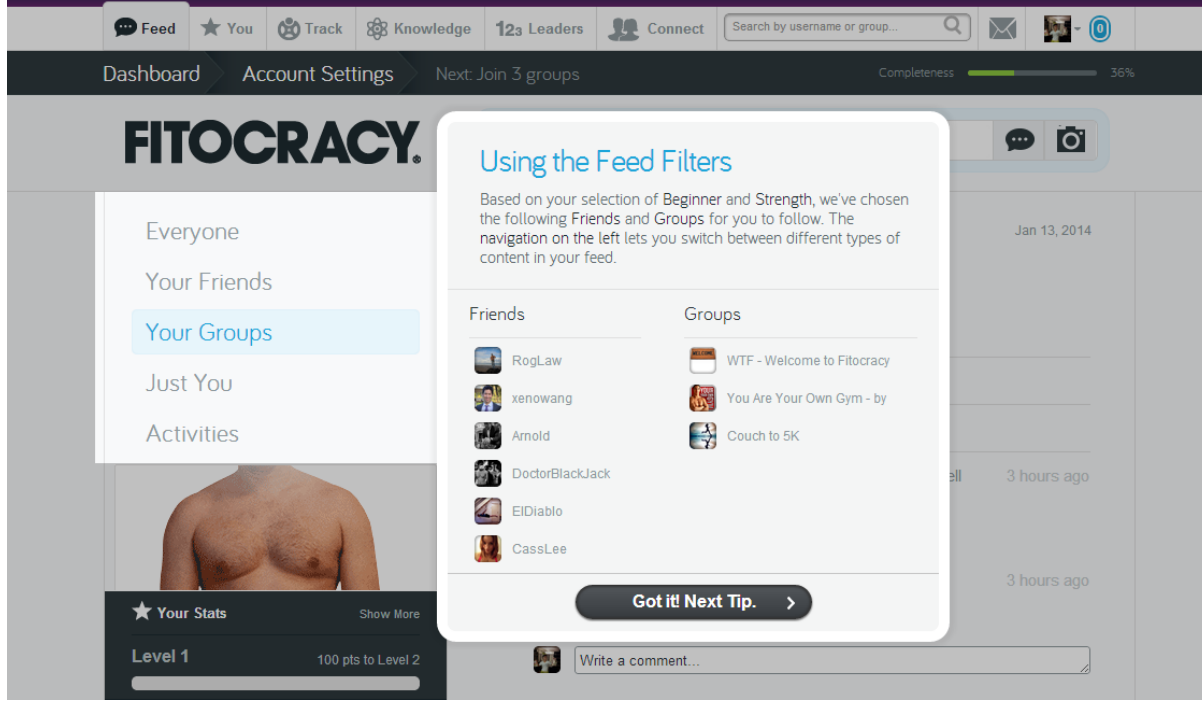
Figure 5. Fitocracy: Interactive engagement